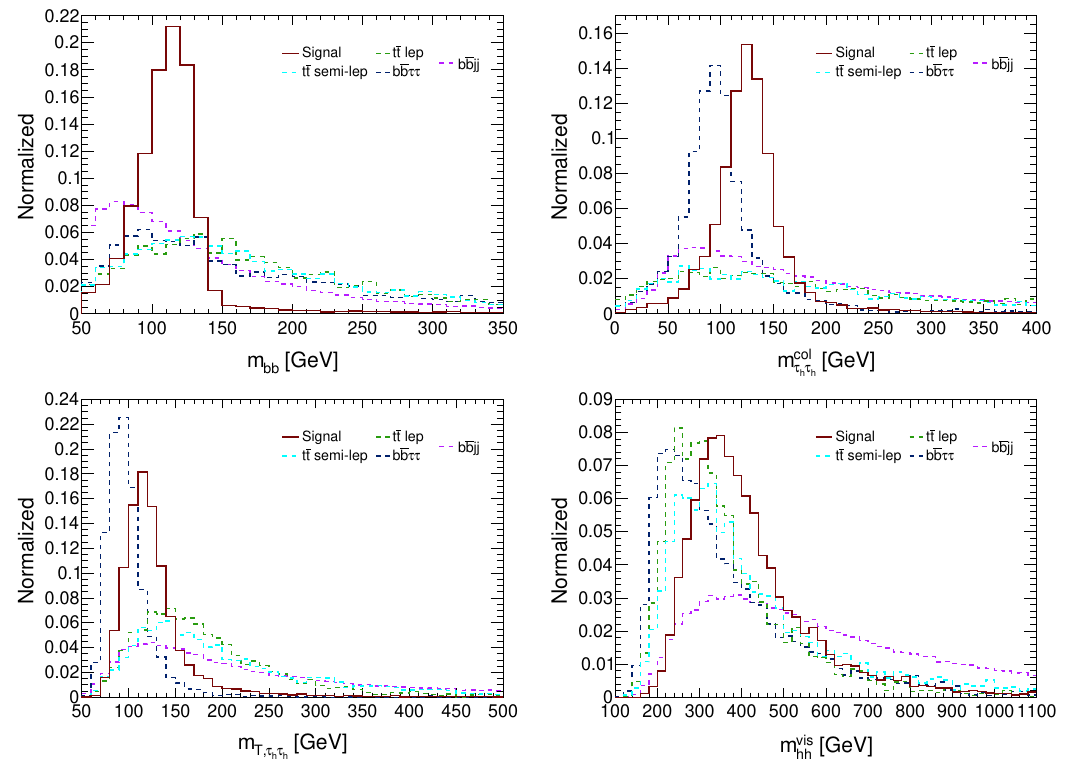
Figure 3 . Normalized distributions of m bb , m col dominant backgrounds after the acceptance cuts and the generation level